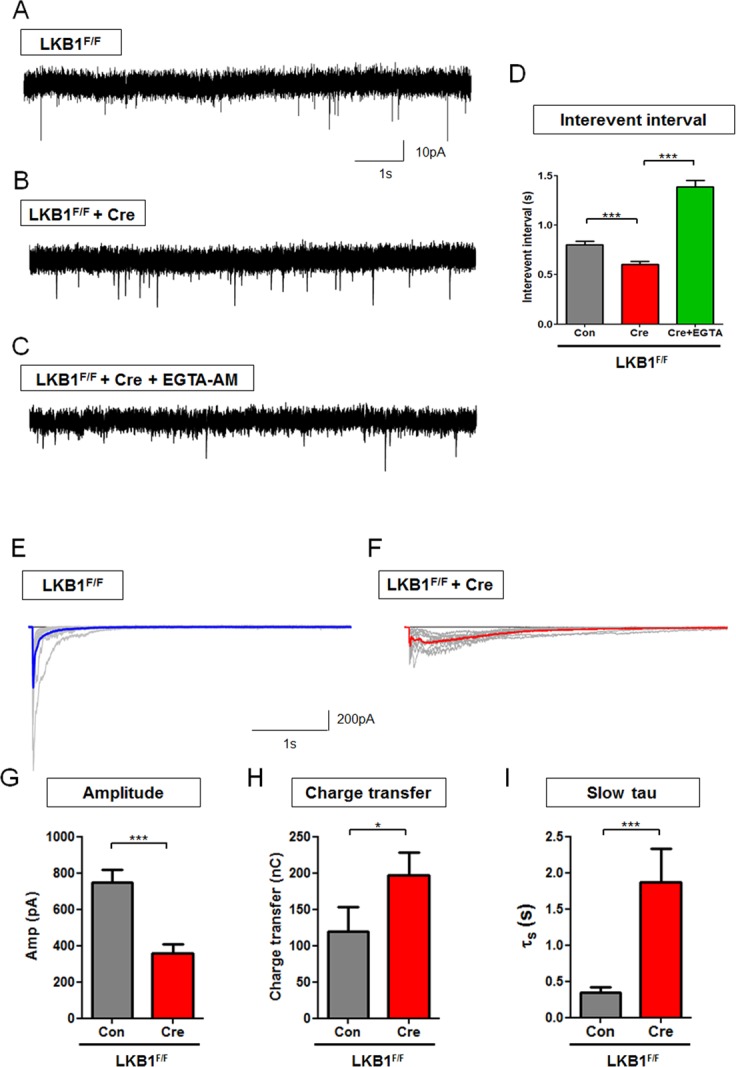
Conditional deletion of LKB1 increases spontaneous neurotransmitter release and asynchronous release in a calcium-dependent manner.(A–D) Conditional deletion of LKB1F/F in cortical pyramidal neurons (E15 + 18 DIV) decreased mEPSC inter-event interval (inversely proportional to frequency) compared to control and this phenotype was rescued by acute application of EGTA-AM (Cre+EGTA-AM). LKB1-floxed mouse cortical neurons were infected by control and Cre viruses at 3–5 DIV and analyzed at 15–18 DIV. n = 3,032 events from 38 neurons for control, 3,159 events from 45 neurons for LKB1-deletion, 1,741 events from 21 neurons for EGTA-AM. *** p < 0.001, Mann-Whitney test. (E–I) Following single AP stimulation, LKB1-deficient cortical neurons showed decreased eEPSC amplitudes, and increased charge transfer and decay constant. (E and F) Colored trace shows averaged of 10 representative eEPSC traces (grey). n = 26 neurons for control, 29 neurons for LKB1-deficient neurons. *** p < 0.001, * p < 0.05, Mann-Whitney test. (G–I) Quantification of eEPSC in control (no Cre) versus LKB1-deficient cortical neurons (+Cre) showed decreased peak amplitude (G), increased total charge transfer due to increased delayed release (H) and increased slow τ component of asynchronous release (I). Individual values are available in S1 Data.